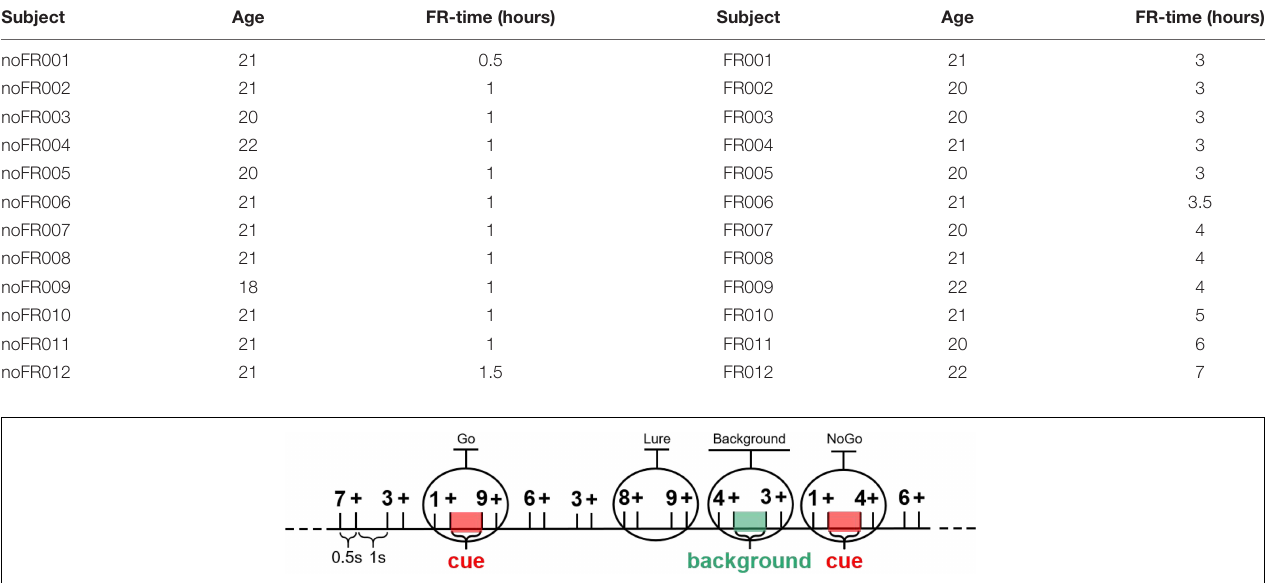
TABLE 1 | Age and FRtime of subjects in two groups.